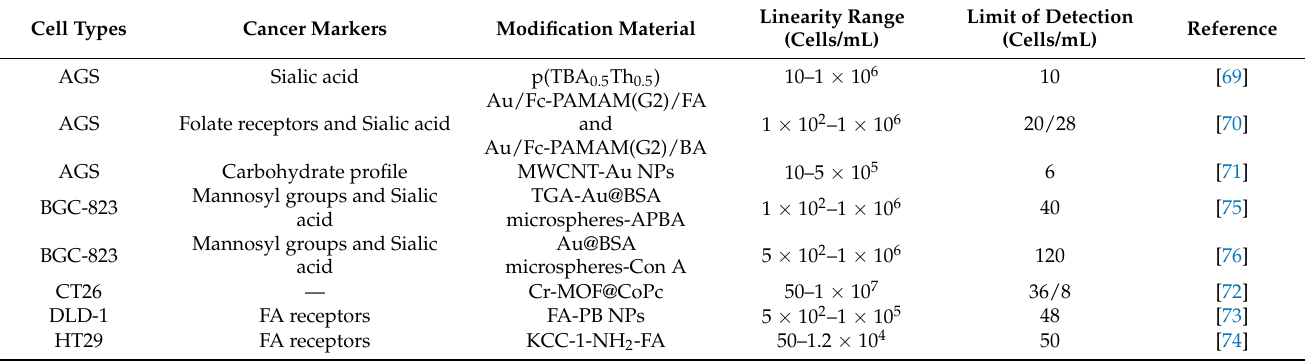
Table 6. Electrochemical cytosensors used for gastric cancer cell and colorectal cancer cell detection. Cell